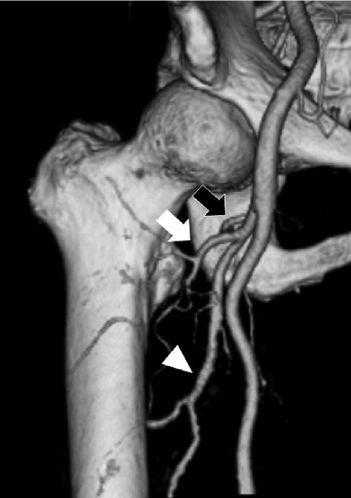
Figure 5. Three-dimensional reconstructed computed tomography image showing arteries that supplied blood to the proximal femur. Lateral femoral circum fl ex artery (white arrow) runs in front of the femur. MFCA (black arrow) delivered blood to the femoral neck and the head from the posterior aspect of the femur. DFA (white triangle) runs along the femoral